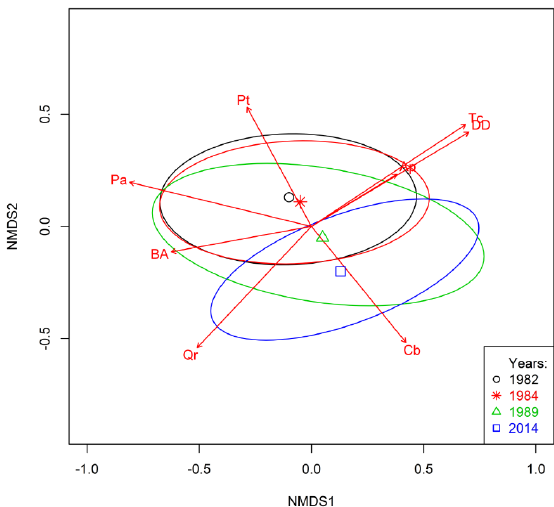
Figure 3. Ordination of study plots in subsequent survey years (ellipse = 1SD from centroid) vs environmental vectors based on nonmetric multidimensional scaling (NMDS). Bray-Curtis Distance. Stress = 0.13. Vectors: BA-total basal area, Qr-basal area of Quercus robur , Cb-basal area of Carpinus betulus , Ap-basal area of Acer platanoides , Tc-basal area of Tilia cordata , Pt-basal area of Populus tremula , Pa-basal area of Picea abies , DD-degree of damage (%). All vectors were significantly correlated with the location of a study plot. R2 for vectors: BA-0.31, Qr-0.33, Cb-0.37, Ap-0.16, Tc-0.52, Pt-0.24, Pa-0.70, DD-0.48.